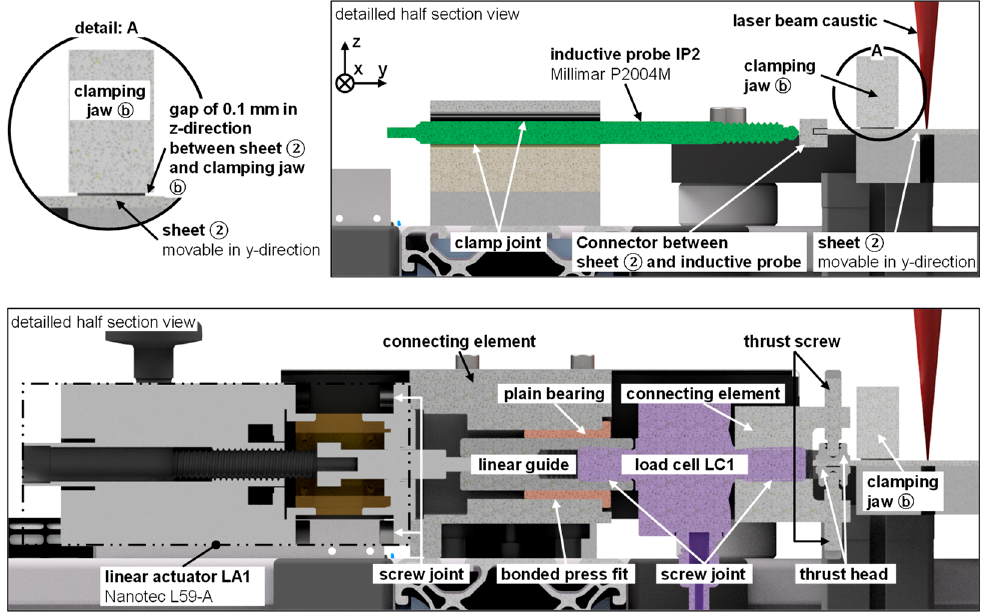
Figure 3. Design details for integration of inductive probes and linear actuators and load cells (half section view).